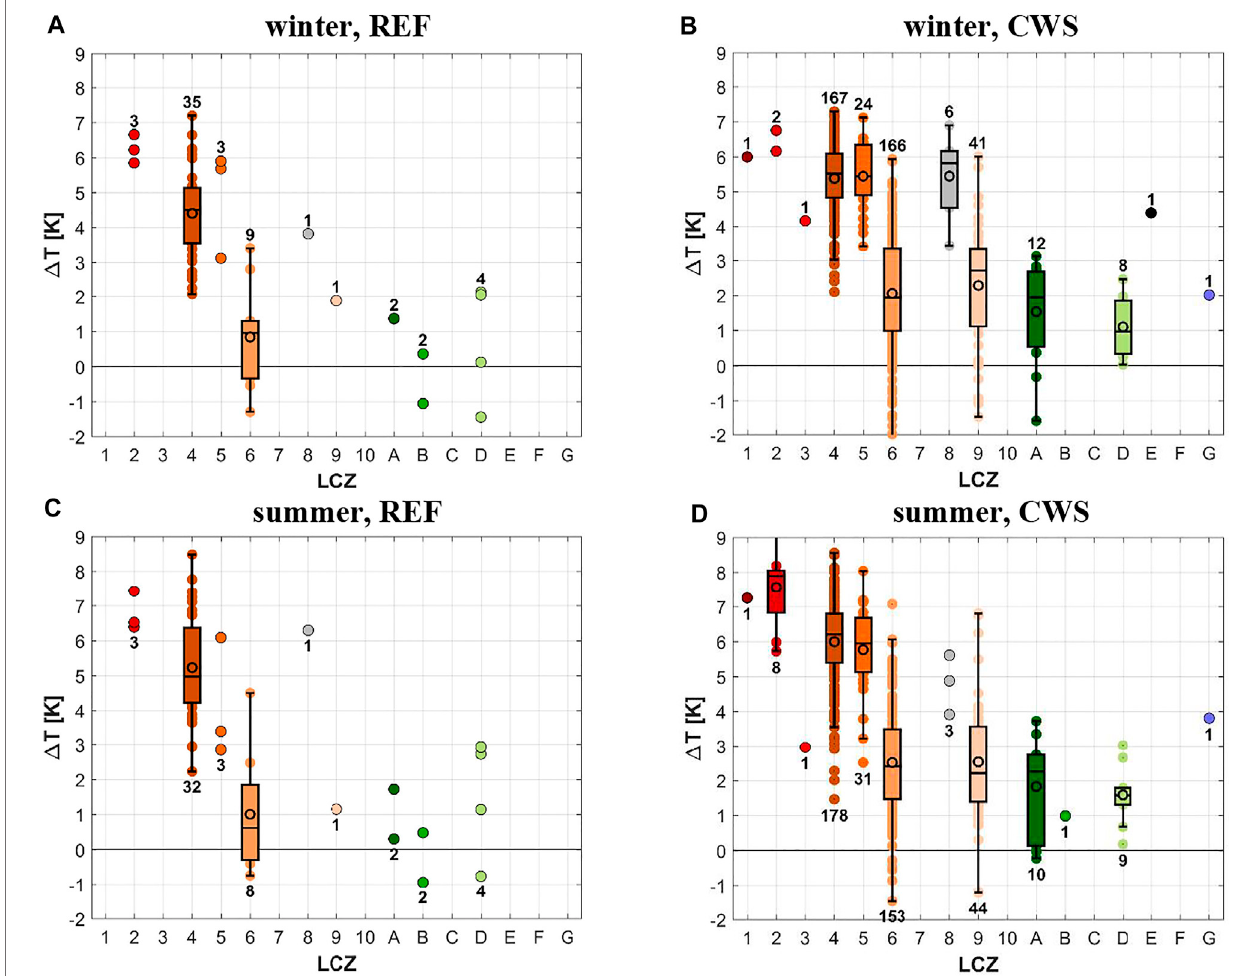
FIGURE 6 | Boxplots representing the dependence between UHI intensity Δ T and LCZ type for winter (A, B) and summer (C, D) based on reference (A, C) and CWS (B, D) observations. Digits in the plots indicate the number of reference stations or CWSs related to speci fi c LCZ types.